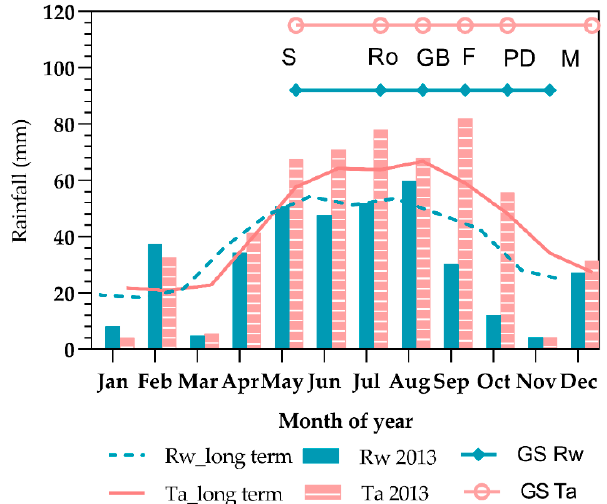
Figure 1. Long-term (1876–2013) mean and monthly rainfall during 2013 at Roseworthy (Rw) and Tarlee (Ta) sites. Growth stages (GS) for Rw and Ta measured on the BBCH canola scale are shown: Sowing (S: GS00), rosette stage (Ro: GS30, green bud appearance (GB: GS51), first flower (F:GS60), PD (GS71) and maturity (M: GS97) [39].